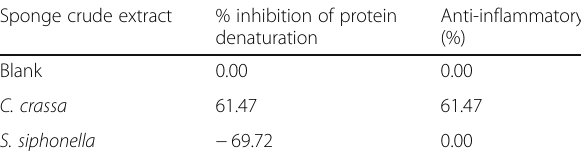
Table 4 Anti-inflammatory activity of different sponge crude extracts